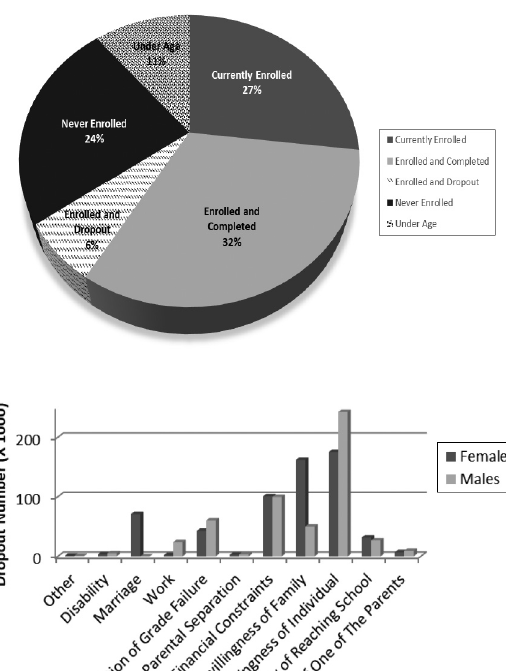
Figure 3. A bar chart showing the possible dropout causes